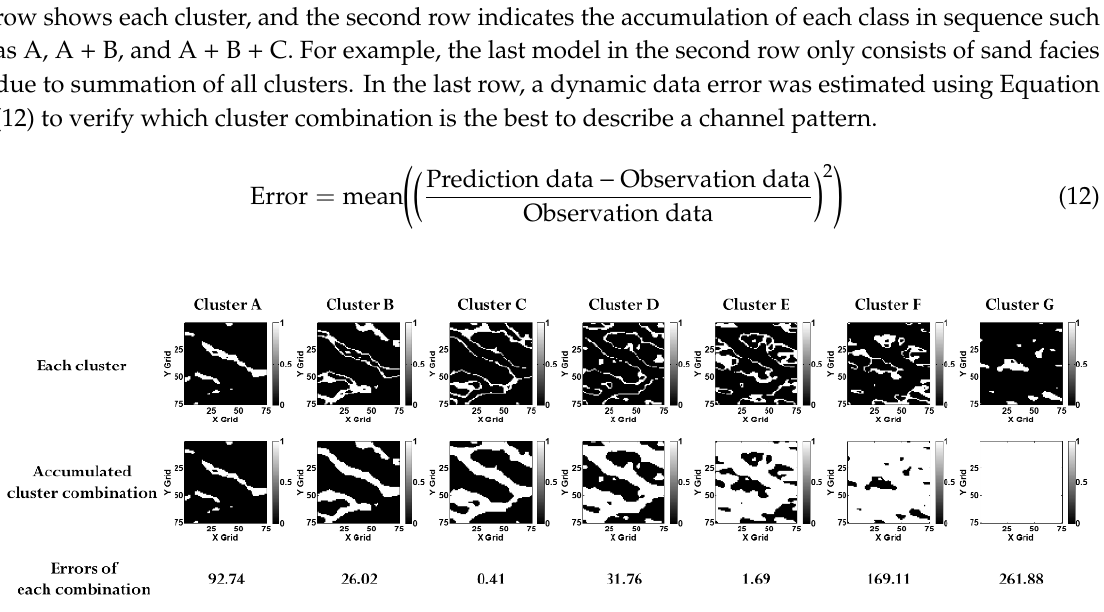
Figure 5. Facies distributions of each cluster and cluster combination with average errors of dynamic data.